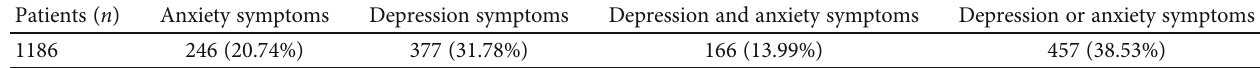
Table 1: Overall detection rates of anxiety and depression